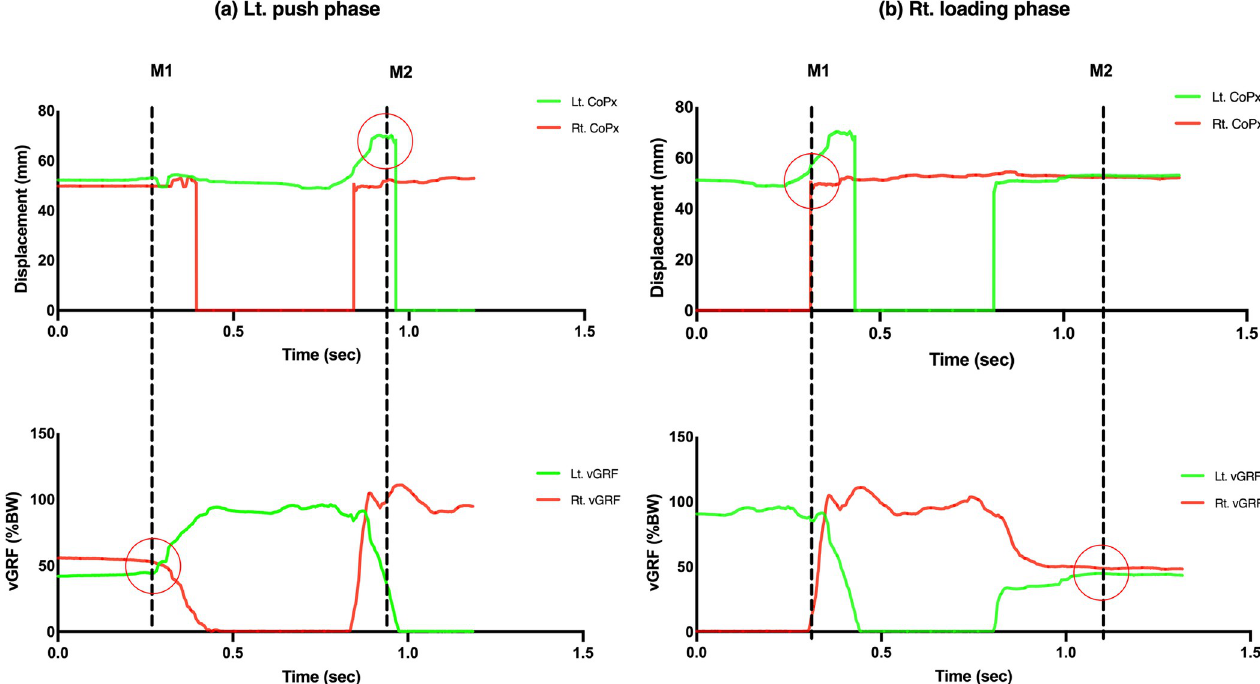
Fig 3. Marking example of the start (M1) and end (M2) point for a single (a) “left push phase” and a single (b) “right loading phase”. Red circles indicate the moment for M1 and M2. CoPx: center of pressure mediolateral displacement; vGRF: vertical ground reaction force.